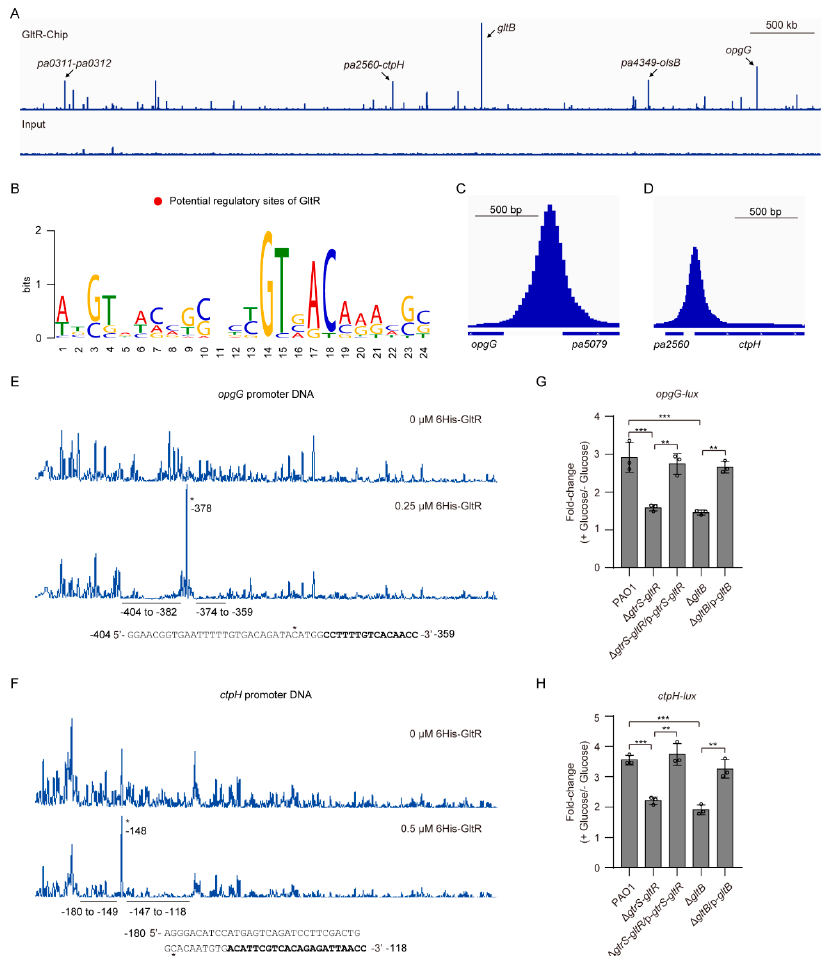
Figure 7. Genome-wide identification of GltR targets. ( A ) Images showing GltR-binding sites identified by CHIP-seq. The top five of CHIP-seq peaks were labeled. ( B ) The most significant motif (E-value = 1.3 × 10 − 6 ) identified by MEME tool was observed in all DNA sequences of the 16 tested peaks ( ≥ 10-fold enrichment, in average). The height of each letter represents the relative frequency of each base at different position in the consensus sequence. ( C , D ) Pattern of CHIP-seq peaks identified in intergenic regions of opgG-pa5079 (C) and pa2560 - ctpH (D). (E and F) Electropherograms show the protection patterns of the opgG ( E ) and ctpH ( F ) promoter DNA after digestion with DNase I following incubation in the absence or presence of 6His-GltR. The protected region (relative to the start codon) is underlined, and the asterisk indicates the DNase I hypersensitivity site. The sequences including GltR-protected regions are shown, and the conserved sequence identified by MEME of GltR-binding sites are shown in bold. (G and H) Effect of either gtrS-gltR or gltB deletion on the expression of opgG-lux ( G ) and ctpH-lux ( H ). Bacteria were grown in tubes containing M9 MM supplemented with (+) or without ( − ) 5 mM glucose at 37 ◦ C with shaking (250 rpm) for 8 h. Data from n = 3 biological replicates reported as mean ± SD. (** p < 0.01, *** p < 0.001; Student’s two-tailed t -test). PAO1, ∆ gtrS-gltR, and ∆ gltB harbor an empty pAK1900 vector as control; p- gtrS-gltR denotes the pAK1900- gtrS-gltR plasmid; p- gltB denotes the pAK1900- gltB